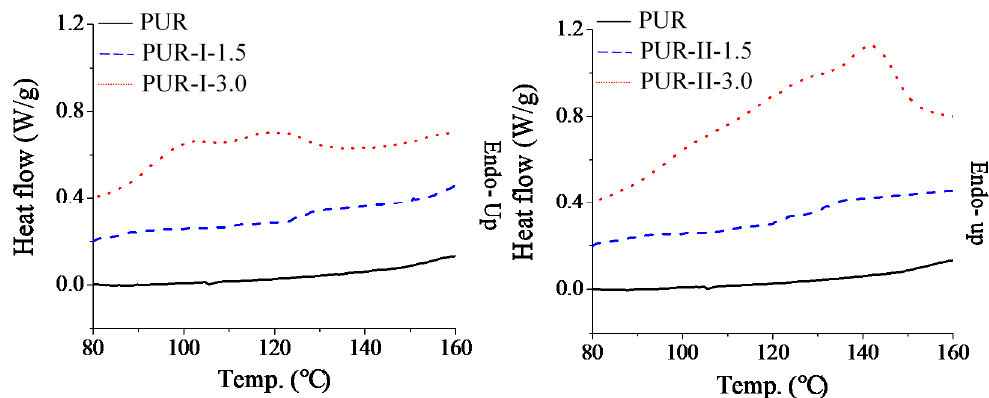
Figure 5. DSC thermal analysis of various cured PUR.